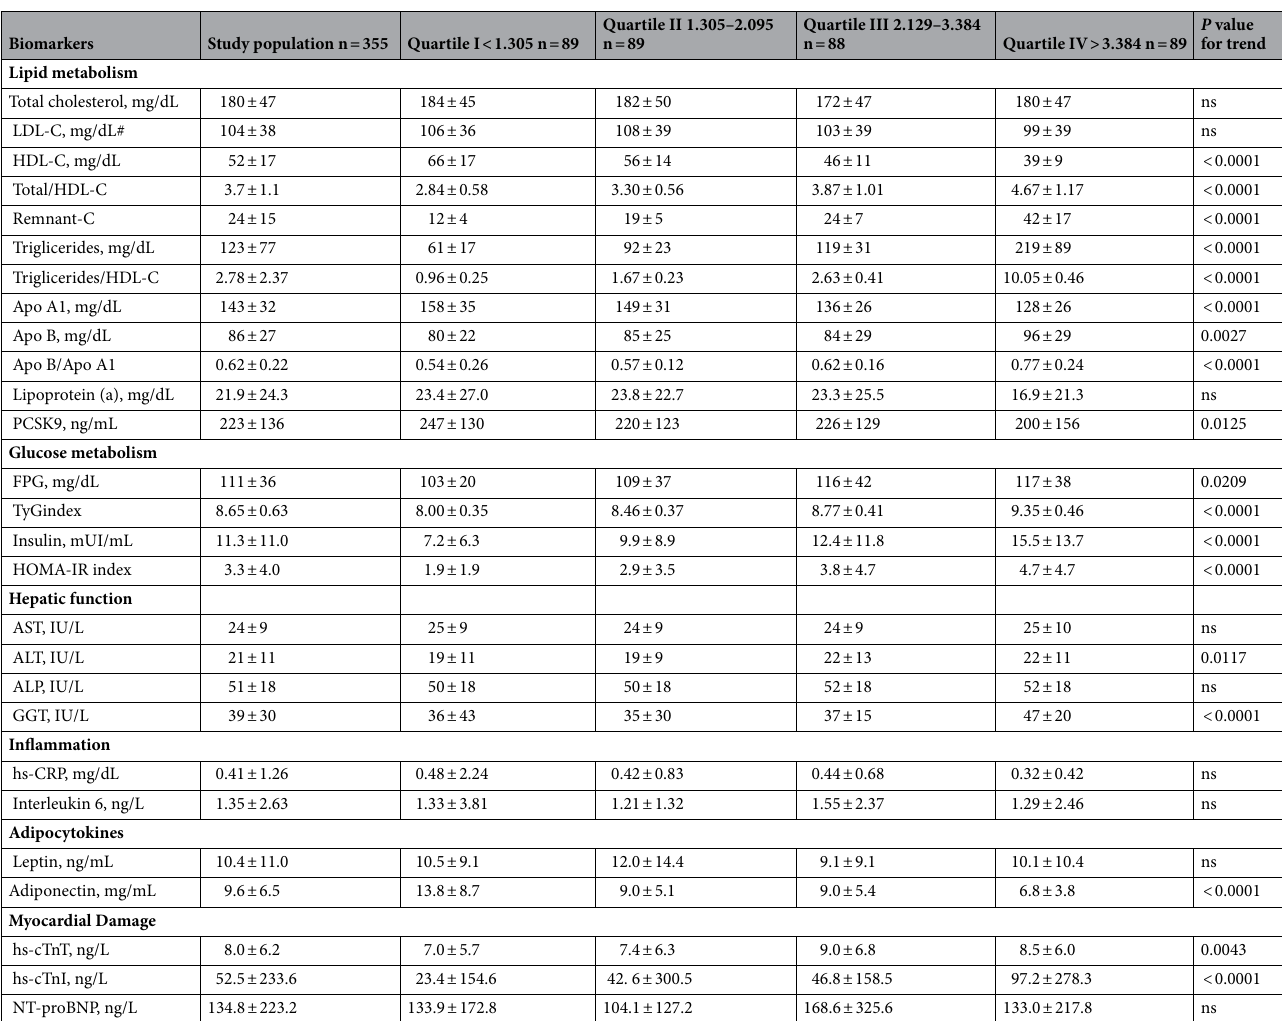
Table 2. Bio-humoral data of the study population and of groups defined by TG/HDL-C quartiles. [Continuous variables are presented as mean ± standard deviation; # = LDL-C was not calculated in 3 patients with TG > 400 mg/dL in the IV